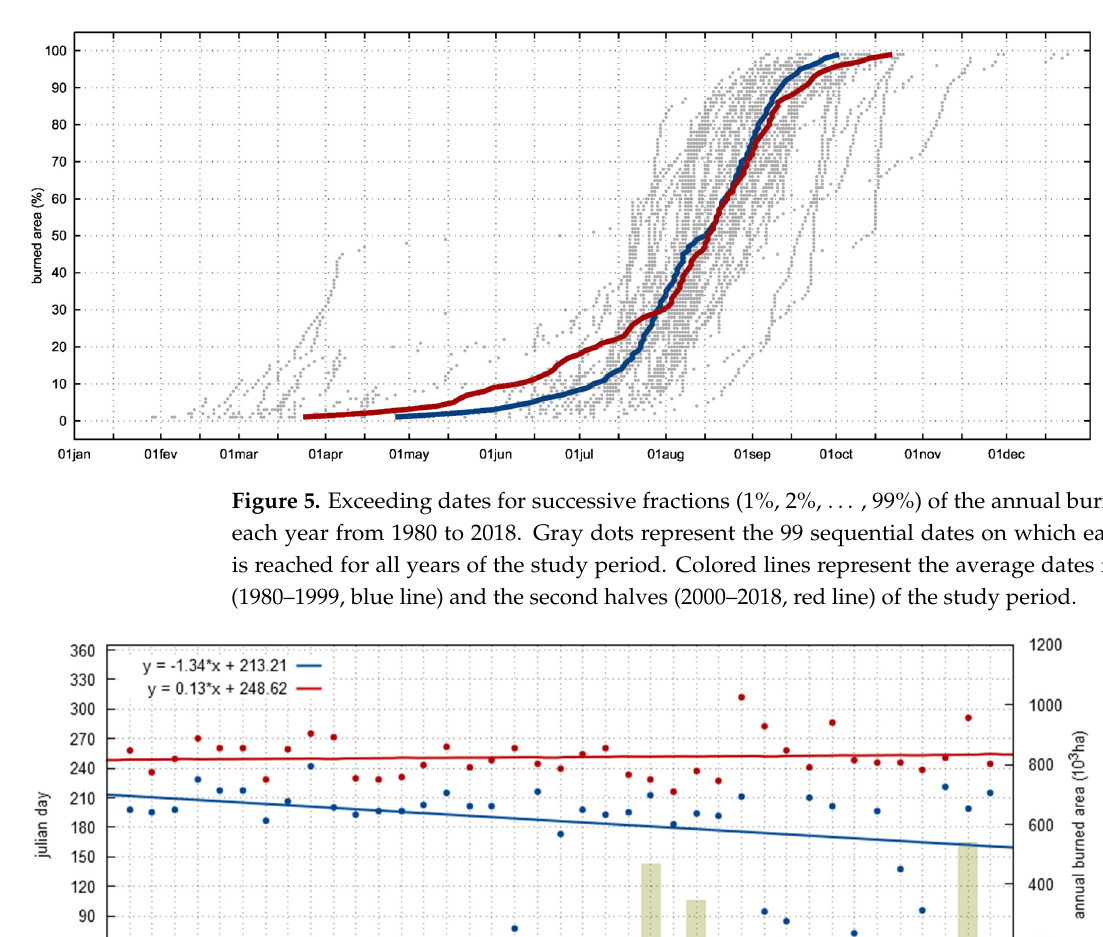
Figure 4. Annual evolution of the fraction of annual burned area recorded before (brown bars, Jan- Jun months with increasing trend, ρ -value = 0.0052), during (orange bars, Jul-Set months with de- creasing trend, ρ -value = 0.0011) and after (yellow bars, Oct-Dec months with no trend, ρ -value = 0.0429) the most critical months for wildfire incidence in the period of 1980–2018.